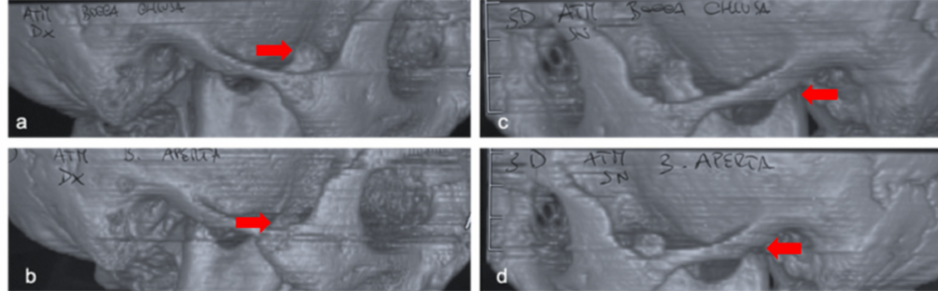
Figure 3. ( a – d ) CBCT scans: ( a ) right side—closed mouth; ( b ) right side—open mouth; ( c ) left side–closed mouth; ( d ) left side—open mouth (age: 10